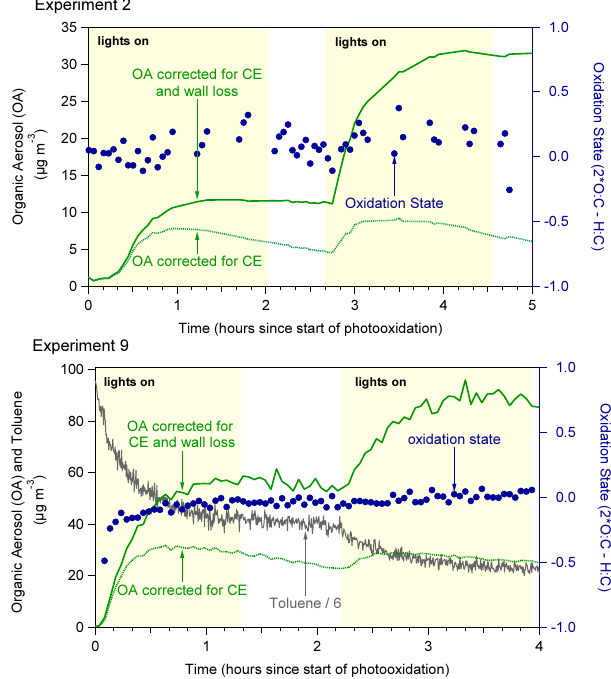
Figure 2. Time series of OA concentration (corrected for CE and corrected for CE and wall loss) from an unseeded experiment (2, top) and a seeded experiment (9, bottom), both with two photo- oxidation periods (“lights on”) before which HONO was injected. The periods during which the reactor was dark are shown with white background while the periods with UV lights are shaded yellow. Also shown is the OA oxidation state (right axis) and concentra- tions of toluene during Expt. 9 (toluene concentrations have been divided by 6 on the figure for easier